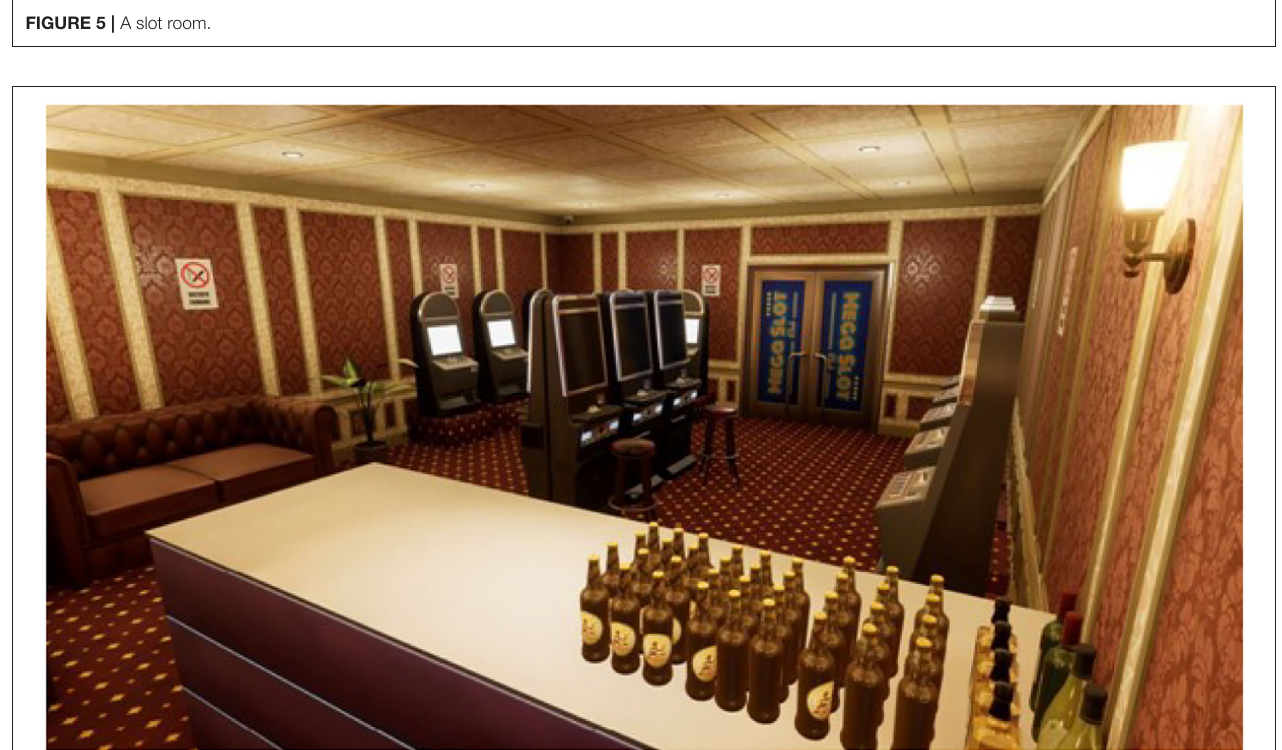
FIGURE 6 | A slot room with some alcohol cues present in Exludo.